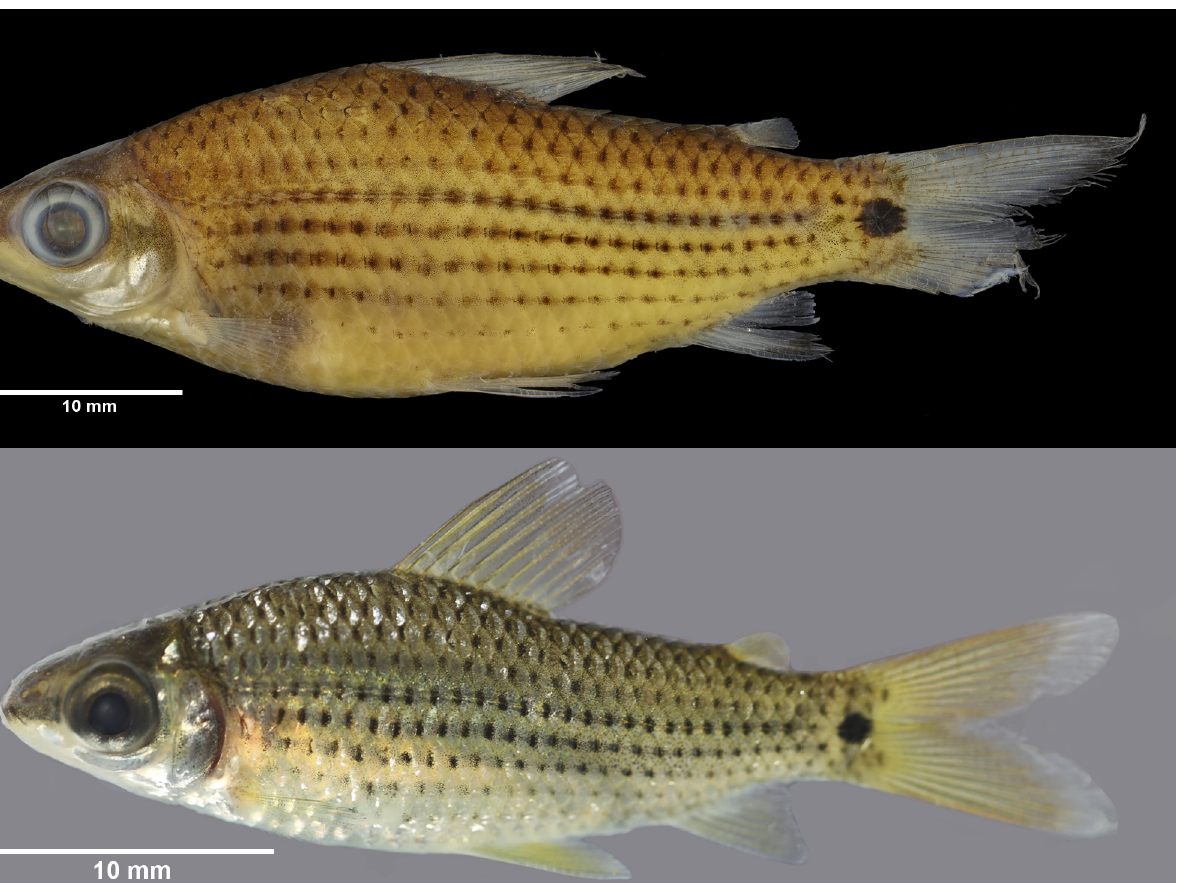
FIGURE 1 | Cyphocharax cramptoni ; A. holotype, ZUE C 17124, 49.7 mm SL, Brazil, Pará, Santarém, rio Mentaí; B. Living specimen, ZUEC 12071, 30.2 mm SL, same data as